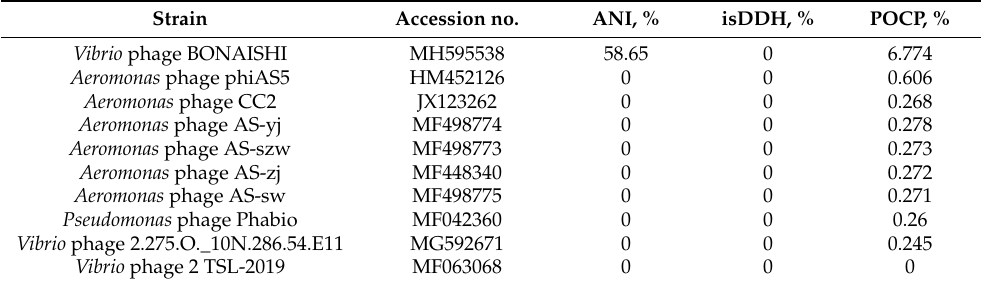
Table 2. Average nucleotide identity (ANI), in silico DNA–DNA hybridization (isDDH) and percent- age of conserved proteins (POCP) values between Vibrio phage Yong-XC31 and the giant phages with the 10 top highest homology in BLASTn comparison (e-value < 10 − 5